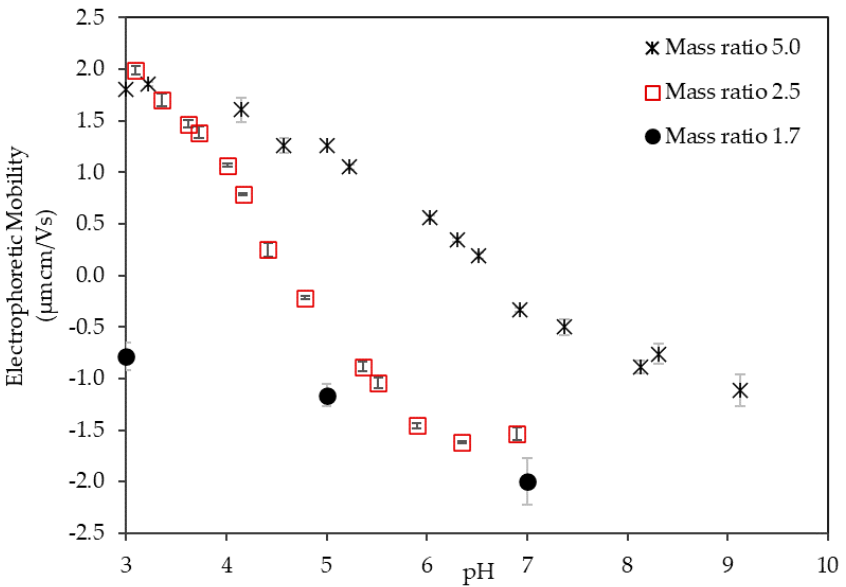
Figure 3. Electrophoretic mobility of the LSZ–LHA complex as a function of pH in 10 mM KCl at different mass ratios (1.7, 2.5, and 5).